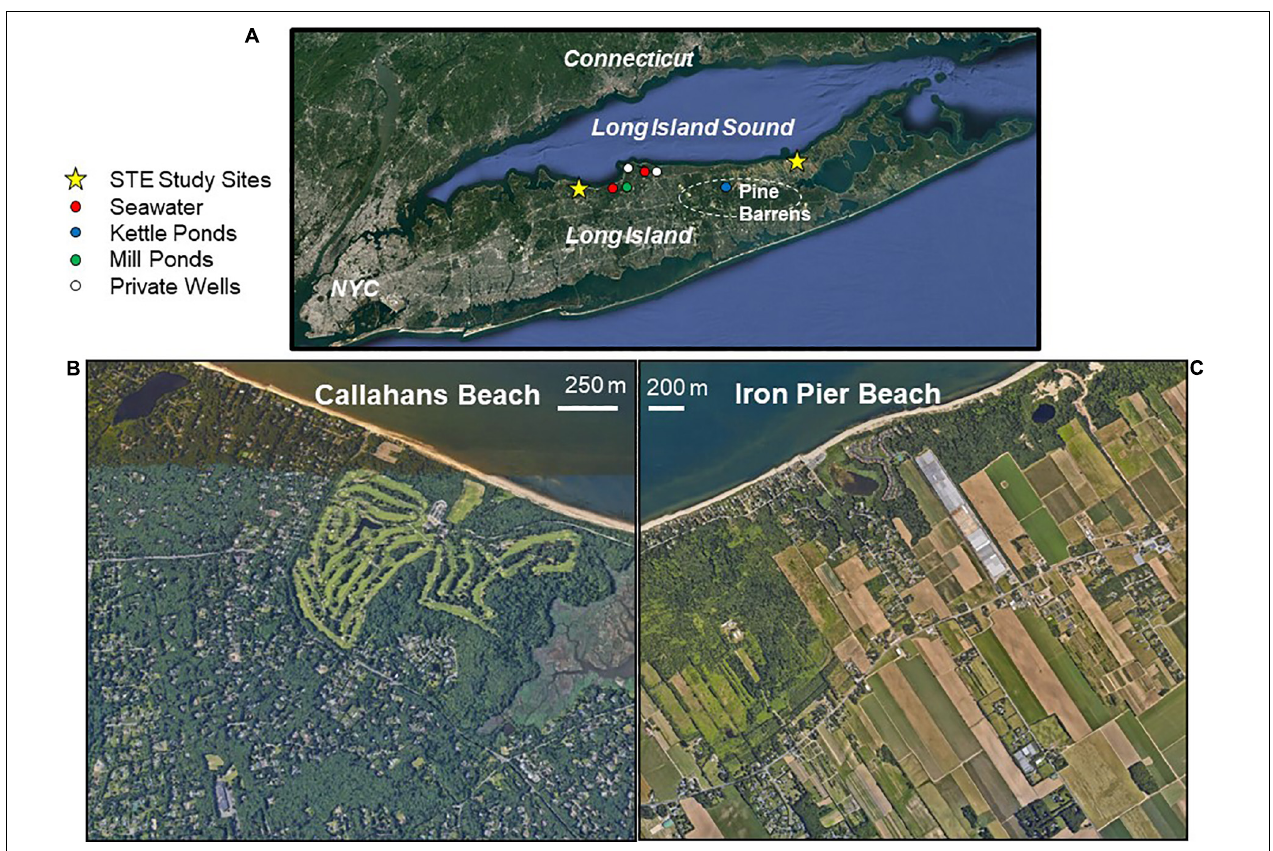
FIGURE 1 | Long Island, NY, United States (A) and the subterranean estuary (STE) study sites of Callahans Beach (B) and Iron Pier Beach (C) , indicated by yellow stars. A survey of water samples from groundwater wells, spring-fed creeks (Mill Ponds) and precipitation-fed ponds (Kettle Ponds) are shown in panel (A)